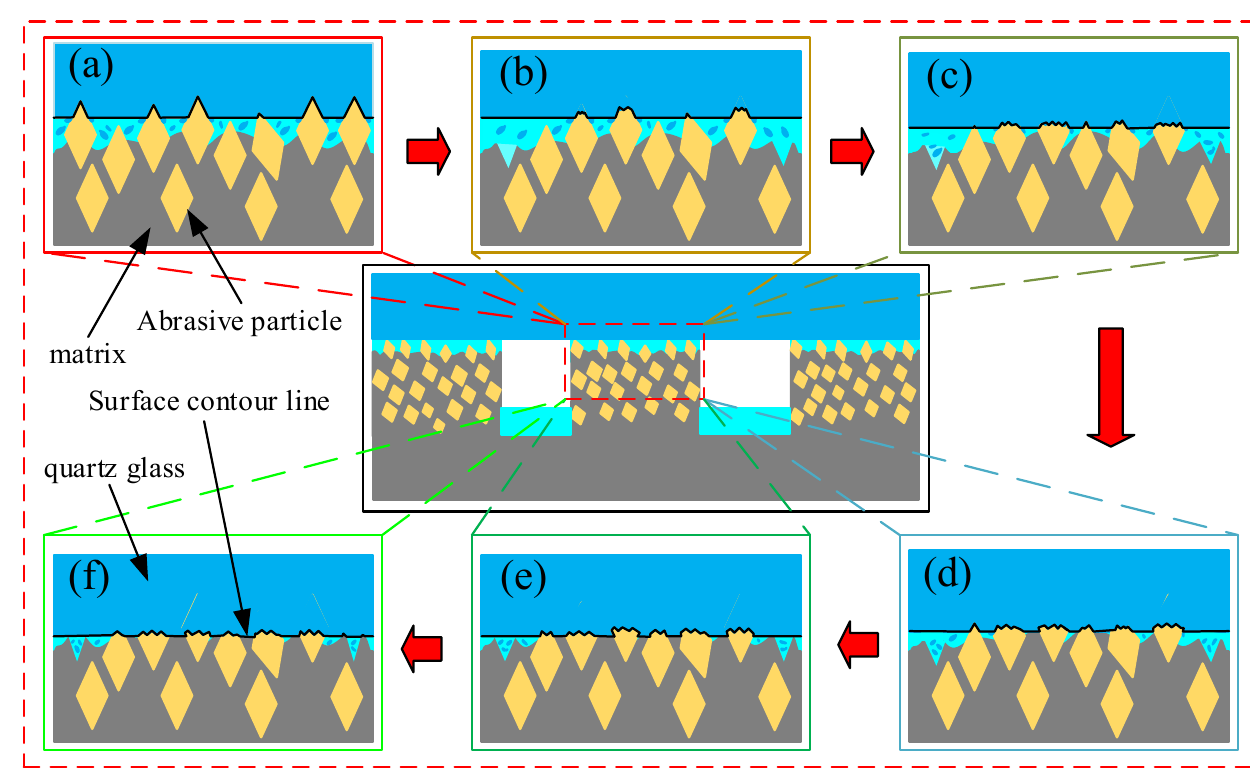
Figure 12. Machining wear principle of the FAP. Note: ( a ) Lapping time 0 – 30 min; ( b ) lapping time 30 – 60 min; ( c ) lapping time 60 – 90 min; ( d ) lapping time 90 – 120 min; ( e ) lapping time 120 – 150 min; ( f ) lapping time 150 – 180 min.